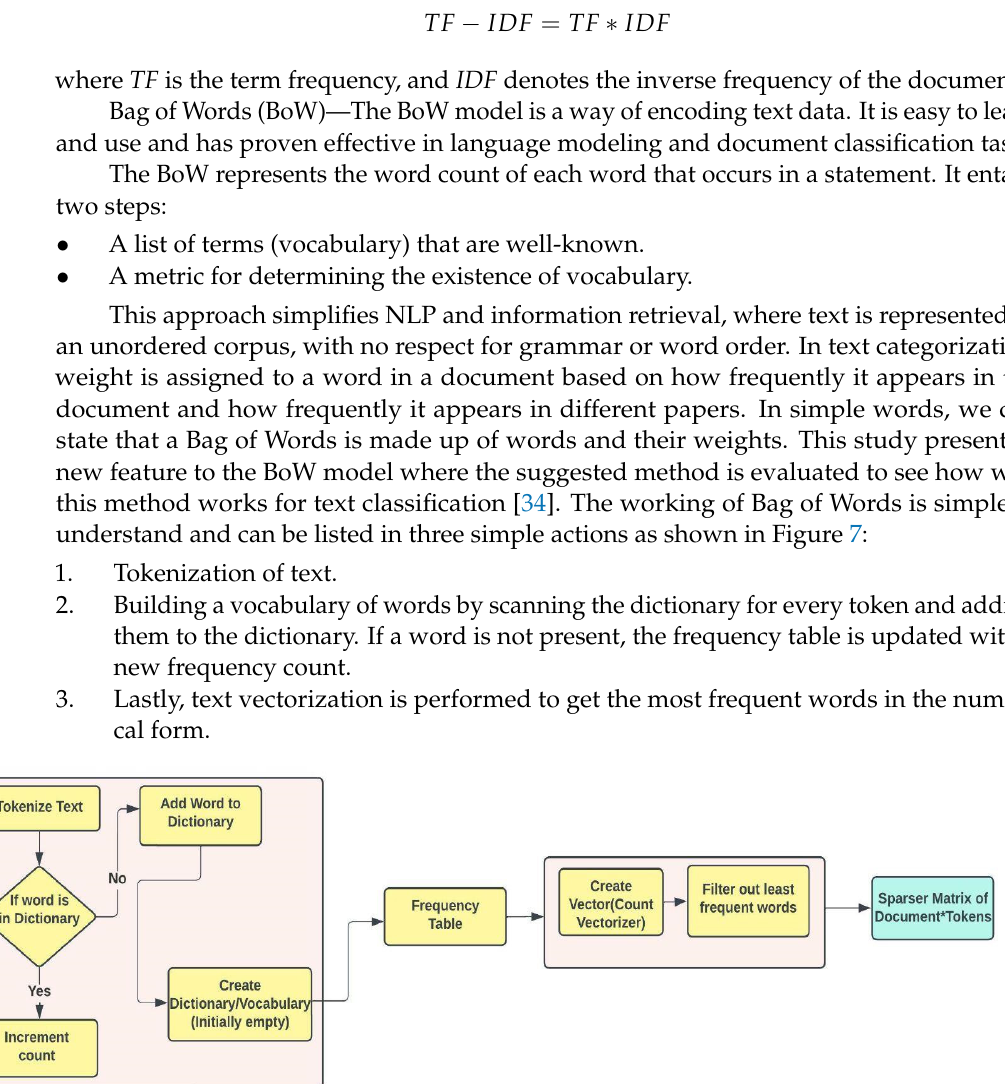
Figure 6. Term Frequency–Inverse Document Frequency workflow to convert text data into feature vectors.